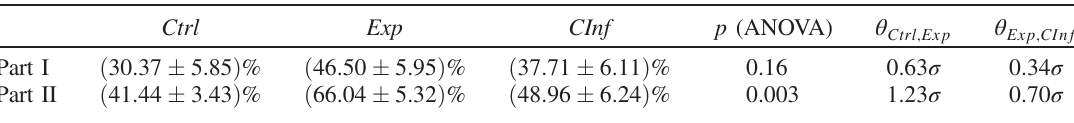
TABLE III. Students ’ total score on both parts of the post-test. Scores are reported as a percentage of points available in each part. The θ column reports the effect size between two groups; σ stands for the pooled standard deviation between the two